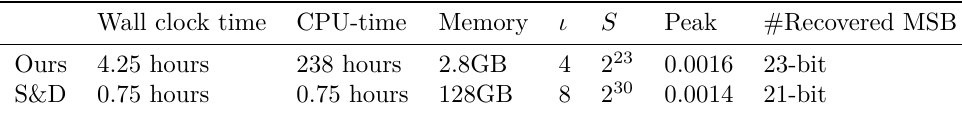
Table 5: Implementation results of the attack against qDSA signatures with nonces of 3-bit bias